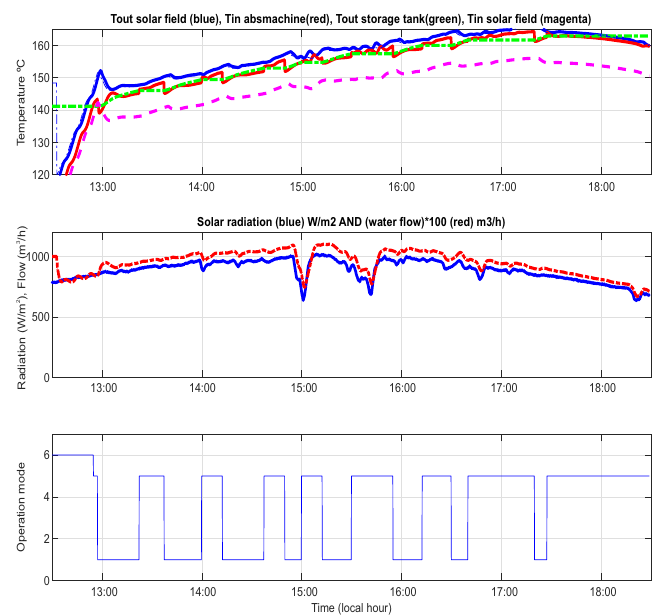
Figure 16. Operation modes in a clear day: storage tank charging.